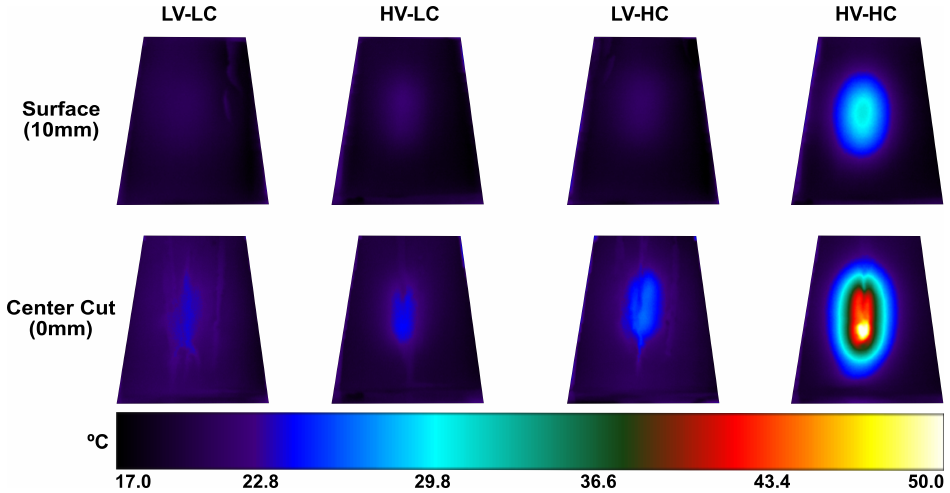
Figure 7. Snapshots taken from the FLIR thermal camera immediately after pulsing at the phantom surface (a distance 10 mm away from the electrode), and shortly after pulsing (within ∼ 5 s) at the center of the phantom in the plane of the electrode